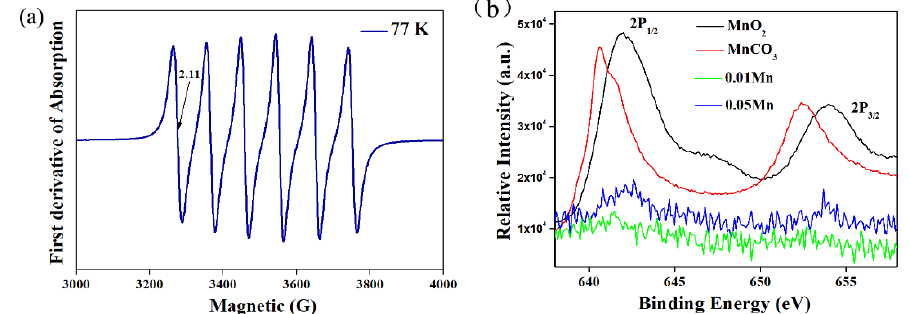
Figure 3. ( a ) Electron paramagnetic resonance (EPR) spectrum of LMA/0.01Mn 4+ at 77 K; ( b ) the Mn 2 p X-ray photoelectron spectroscopy (XPS) spectra of MnO 2 , MnCO 3 , and LMA/0.01Mn 4+ and LMA/0.05Mn 4+ .